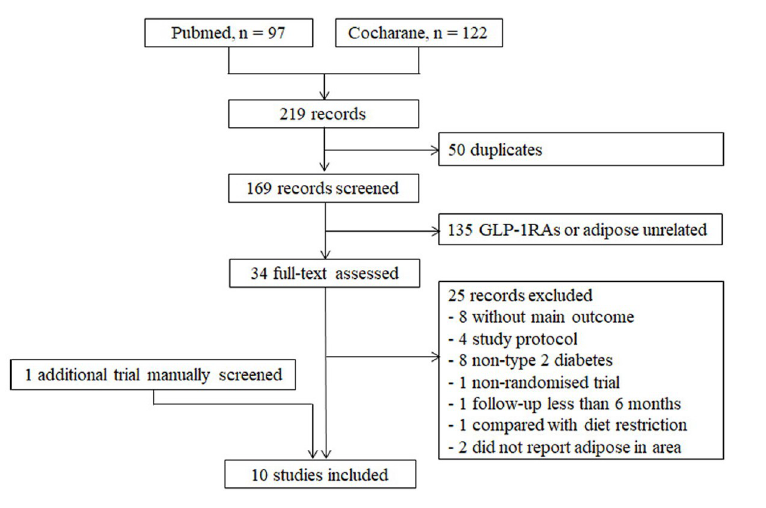
Fig 1. Study flow